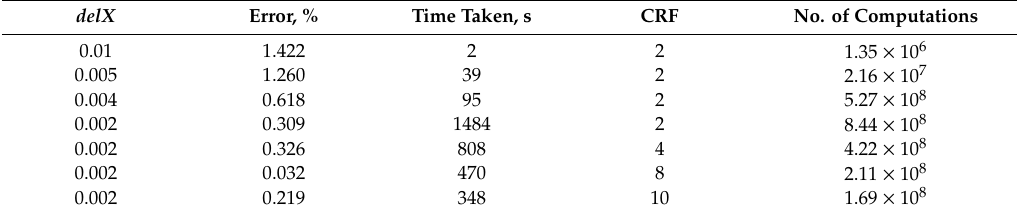
Table 2. Computation of view factor using UGMC routine. Example with perpendicular, whole surfaces, uniform reflectance. Routine: Uniform Grid Monte-Carlo, UGMC *.